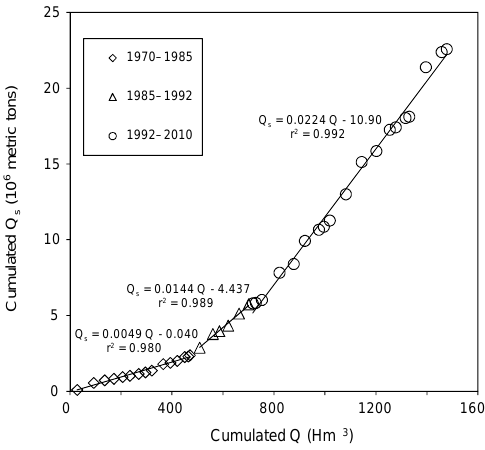
Figure 9. Double-mass plot of sediment yield versus water